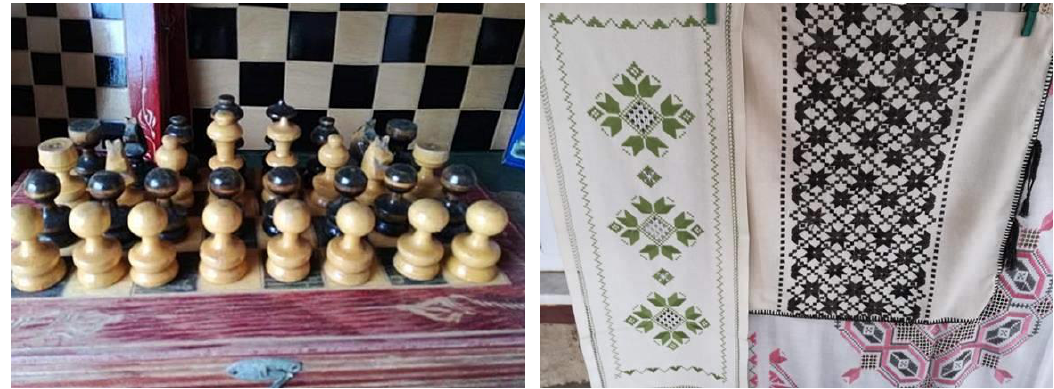
Figure 7: Examples of handicrafts sold at Izvoru Crișului Photos by Mădălin-Sebastian LUNG,